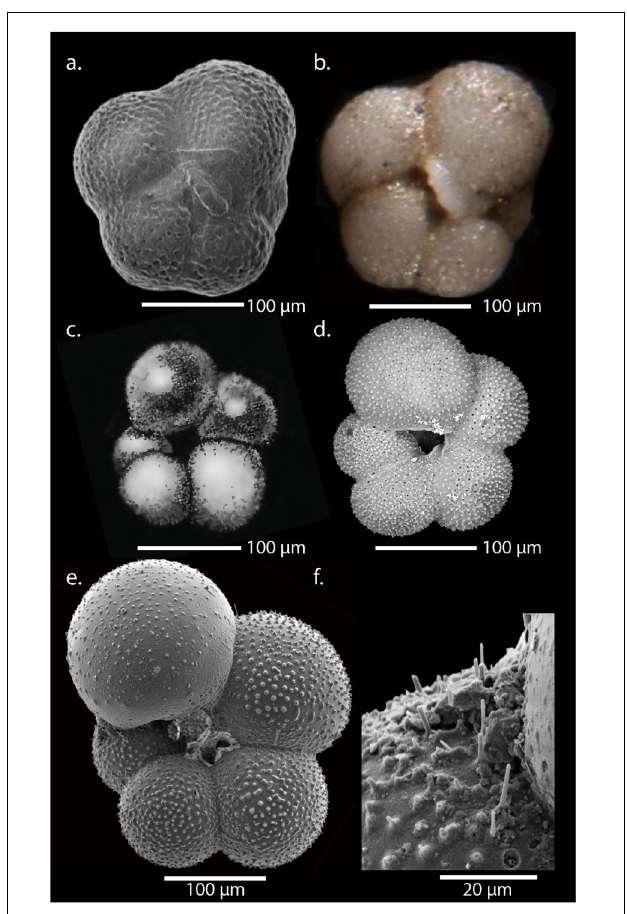
FIGURE 9 | (a) SEM and (b) light microscope images of the holotype of T. quinqueloba (Natland), USNM 3154044. (c) Type illustration of the holotype of Globigerina egelida Ciffelli and Smith (specimen lost from the USNM collection, Brian Huber, pers comm.). (d) SEM image of a paratype of G. egelida Ciffelli and Smith (USNM 179188). (e) A specimen identified as Turborotalita egelida from an interval interpreted as MIS 11 in core LOMROG07-4PC, 289–288 cm off Northern Greenland (Hanslik, 2011; Cronin et al., 2014). (f) Close up of image of (e) showing remnant spines indicative of the spinose family Globigerinidae